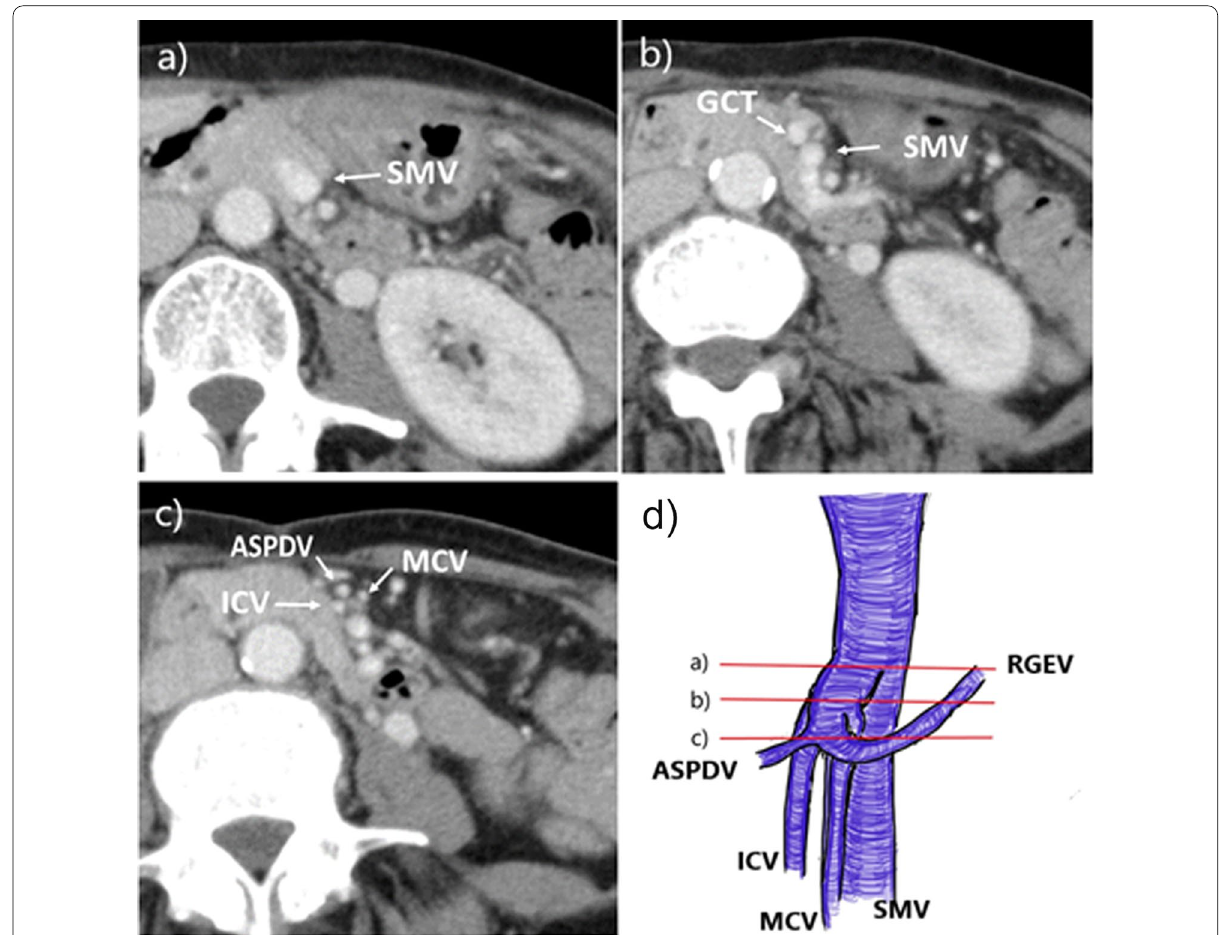
Fig. 3 Contrast-enhanced abdominal computed tomographic scan at different levels showing the ileocolic vein (ICV) draining into the gastrocolic trunk (GCT), along with the anterior superior pancreaticoduodenal vein (ASPDV) and right gastroepiploic vein (RGEV). a Axial view at the level of line (a). b Axial view at the level of line (b). c Axial view at the level of line (c). d A schema of the portal system. Red line: CT slice